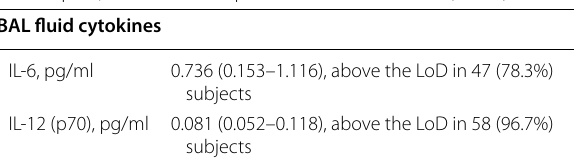
Variables are presented as median and interquartile